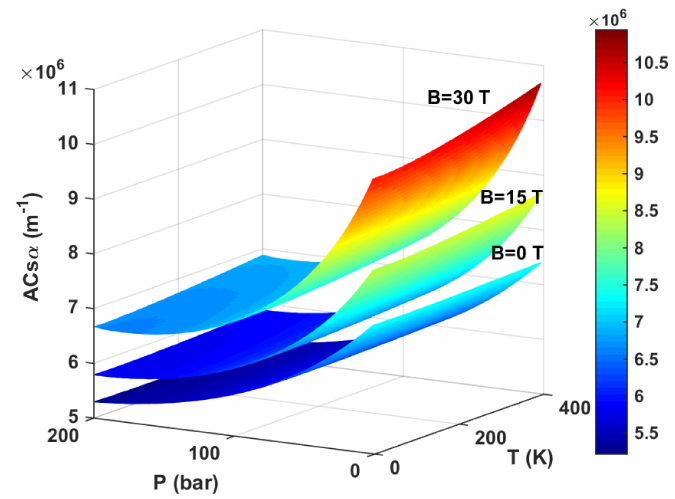
Figure 4. The resonance peak value of total OACs as a function of hydrostatic pressure P , temperature T , and applied magnetic field B with I = 0.6 MW/cm 2 and well width L = 8 nm.